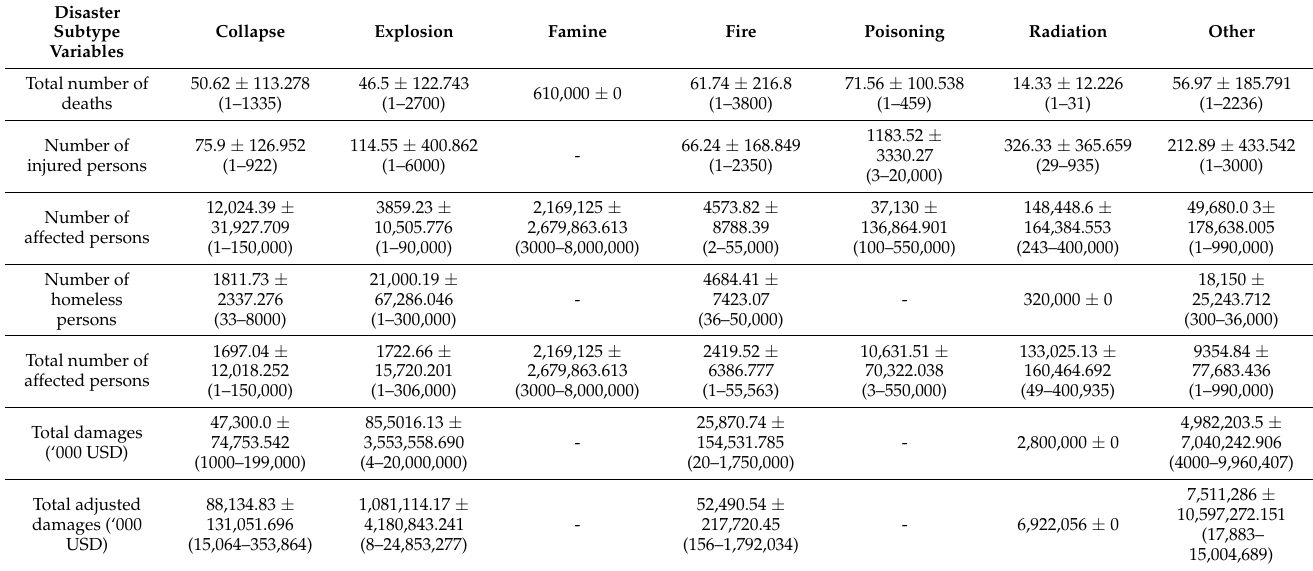
Table 2. Descriptive statistics of the research data according to disaster